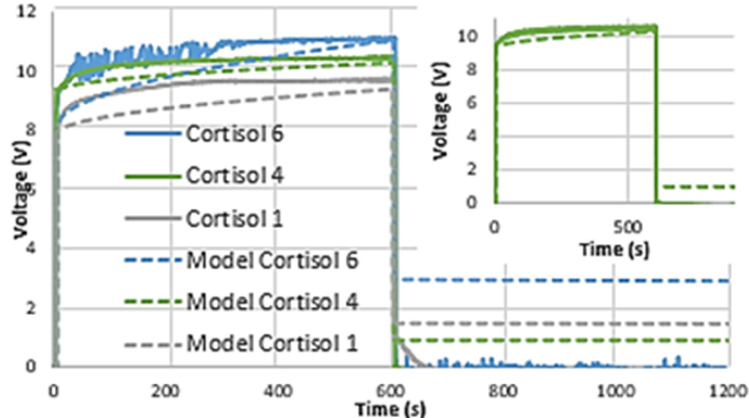
Figure 5. EGOFET equivalent real data compared to equivalent circuit model 1. Inset: Cortisol 4 dilution showing real data to model comparison.